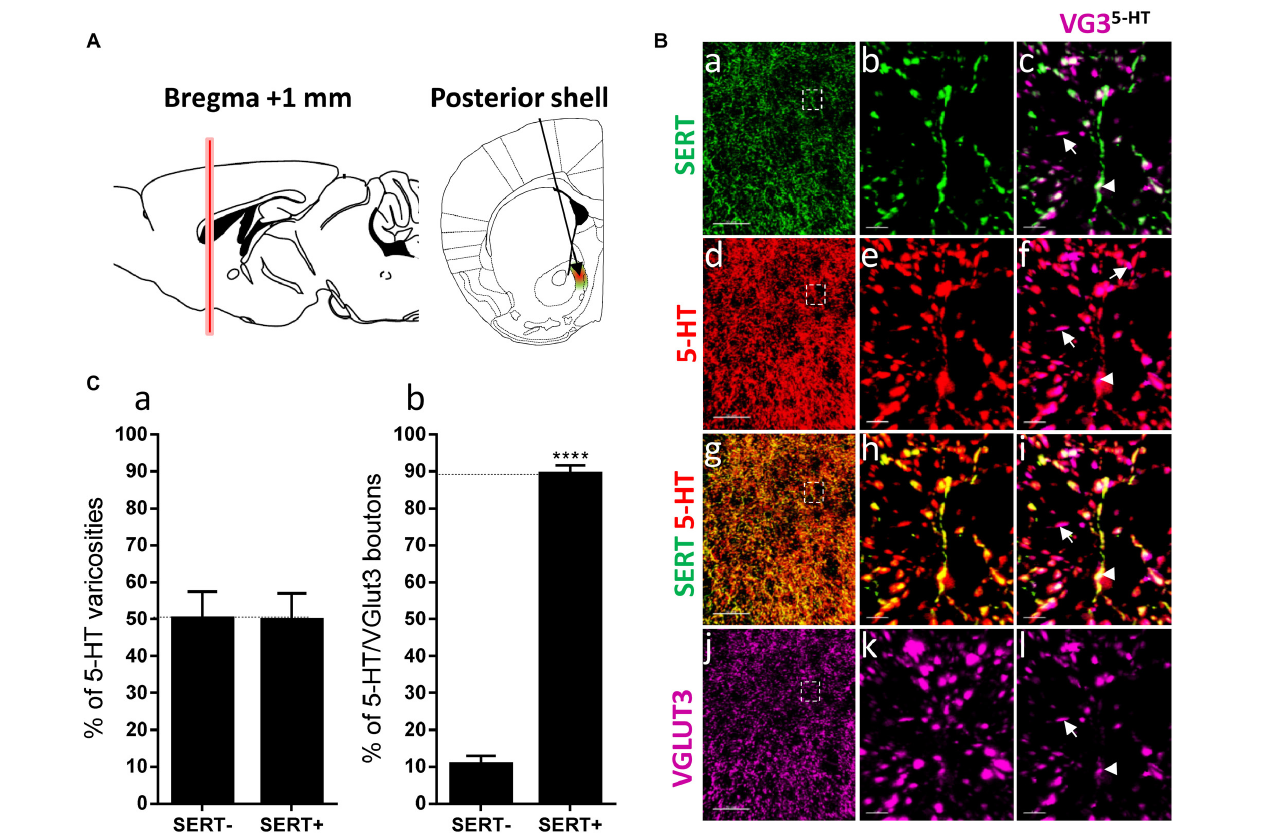
FIGURE 3 | Distribution of VGLUT3 + boutons within 5-HT + and SERT + axons in the posterior shell of the nucleus accumbens. (A) Schematic drawing showing the location of the acquired micrographs. The posterior (caudal) shell of the nucleus accumbens (NAc) (green/red area) mosaic images were acquired at bregma + 1 ± 0.2 mm (red vertical line). (B) Micrograph showing the distribution of the SERT (green, a–c ), 5-HT (red, d–f ), SERT (green) + 5-HT (red) ( g–i ), and VGLUT3 (magenta, j–l ). Right panel ( a,d,g,j ) shows lower magnification. Scale bar: 50 µ m. Middle ( b,e,h,k ) and right ( c,f,i,l ) panels show higher magnification of the white dashed box in the left panel (a,d,g,j) . Scale bar: 2 µ m. The right panel (c,f,i,l) shows the VGLUT3 boutons co-labeled with SERT (c) , 5-HT (f) and SERT + 5-HT (i) . VGLUT3 puncta located within 5-HT varicosities were isolated using Imaris (l) . Arrowheads show 5-HT varicosities collocated with SERT and VGLUT3 (c,f,i,l) .